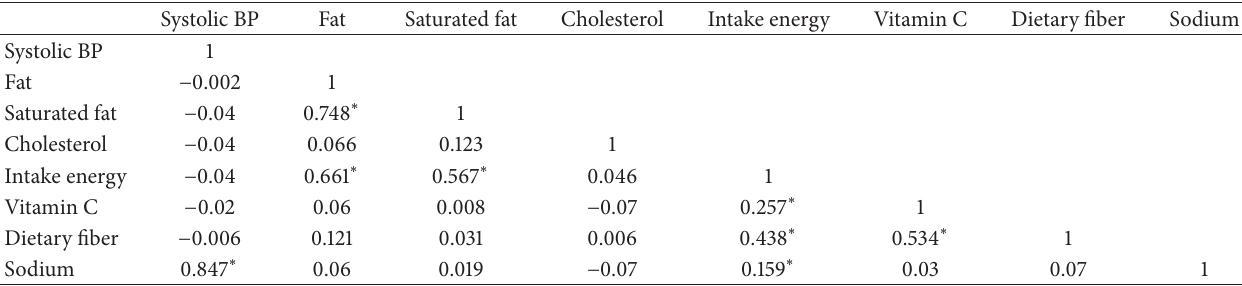
Table 4: Correlation of systolic blood pressure with the variables of dietary behavior in uncontrolled hypertension group. Systolic BP Fat Saturated